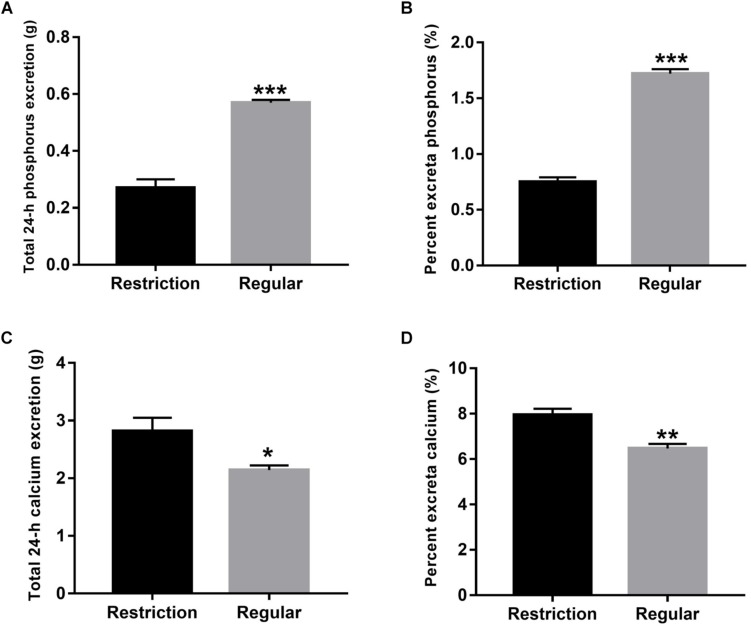
Effects of dietary non-phytate phosphorus levels (restriction, 0.14%; regular, 0.32%) on the excretion of phosphorus [(A) total 24-h phosphorus excretion and (B) percentage phosphorus in excreta] and calcium [(C) total 24-h calcium excretion and (D) percentage calcium in excreta] in laying hens. Values are of 7 hens/treatment. *P < 0.05; **P < 0.01; ***P < 0.001. Experiment 2.